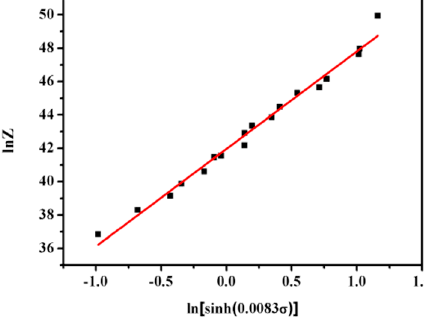
Figure 3. Linear relationship between ln Z and ln[sinh( ασ )].